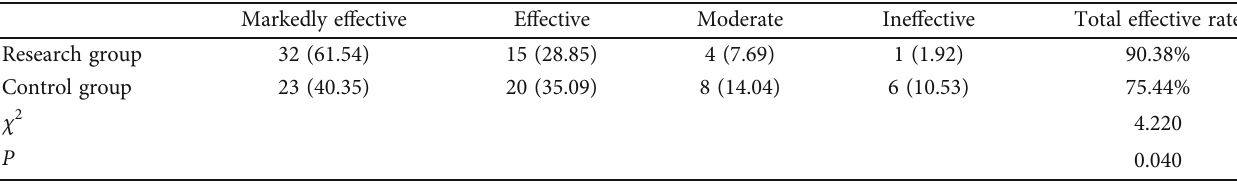
Table 2: Comparison of clinical e ffi cacy ½ n ð % Þ(cid:2) .